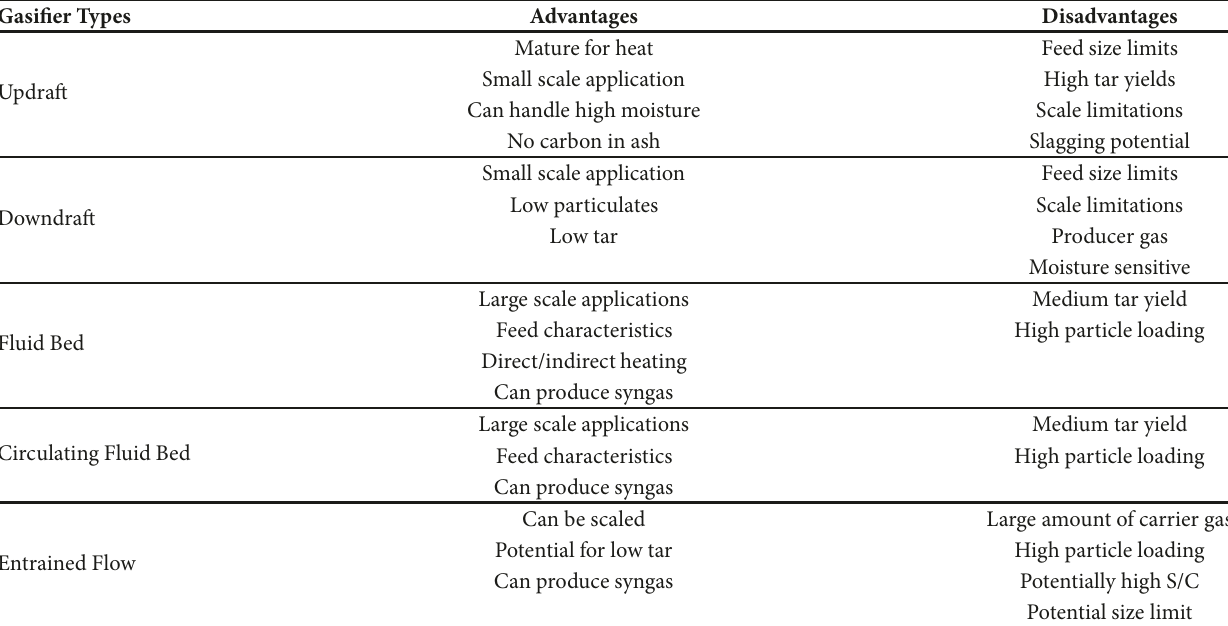
Table 10: Advantages and disadvantages of different types of biomass